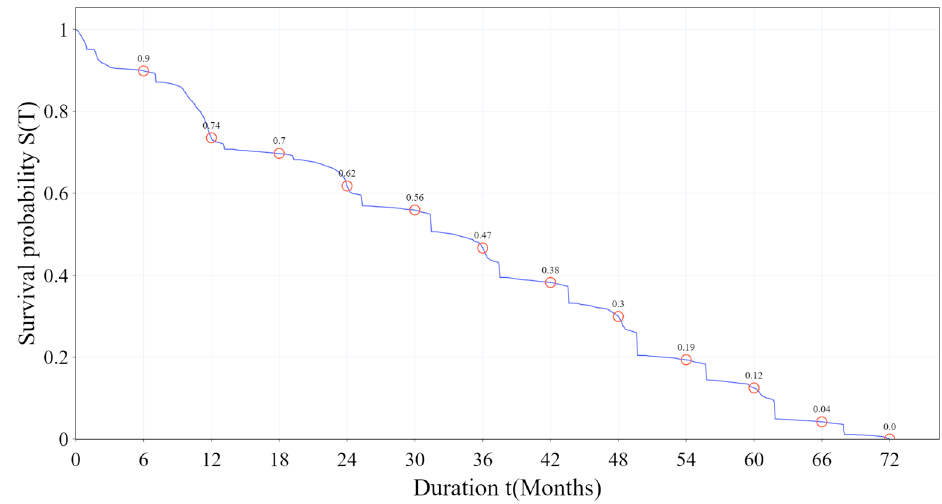
Figure 2. Kaplan Meier Plot for Student Dropout ( n =